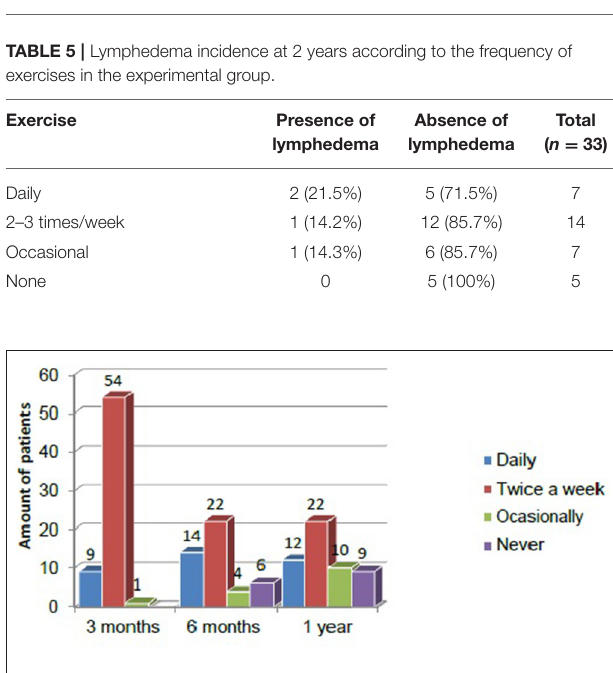
FIGURE 3 | Adherence to exercise over the first year among completers ( n = 60).